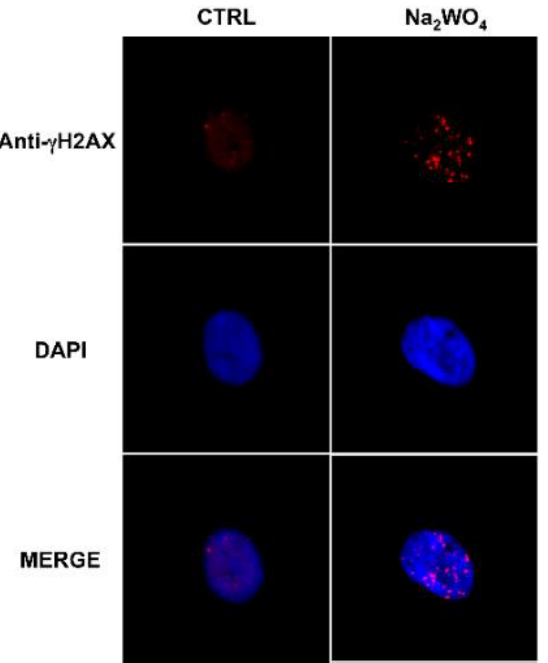
Figure 4. Exposure to a low dose of tungsten affects DNA repair proteins in human thyrospheres . The exposure of human thyrospheres to a low dose of W (Na 2 WO 4 , 30 nM for 90 min) increases the expression of the DNA repair protein γ H2AX. γ H2AX (red) was detected using a γ H2AX antibody followed by an Alexa Fluor-594-conjugated secondary antibody. Nuclei were visualized with DAPI (4 ’ ,6-diamidino-2-phenylindole) (blu) [103].